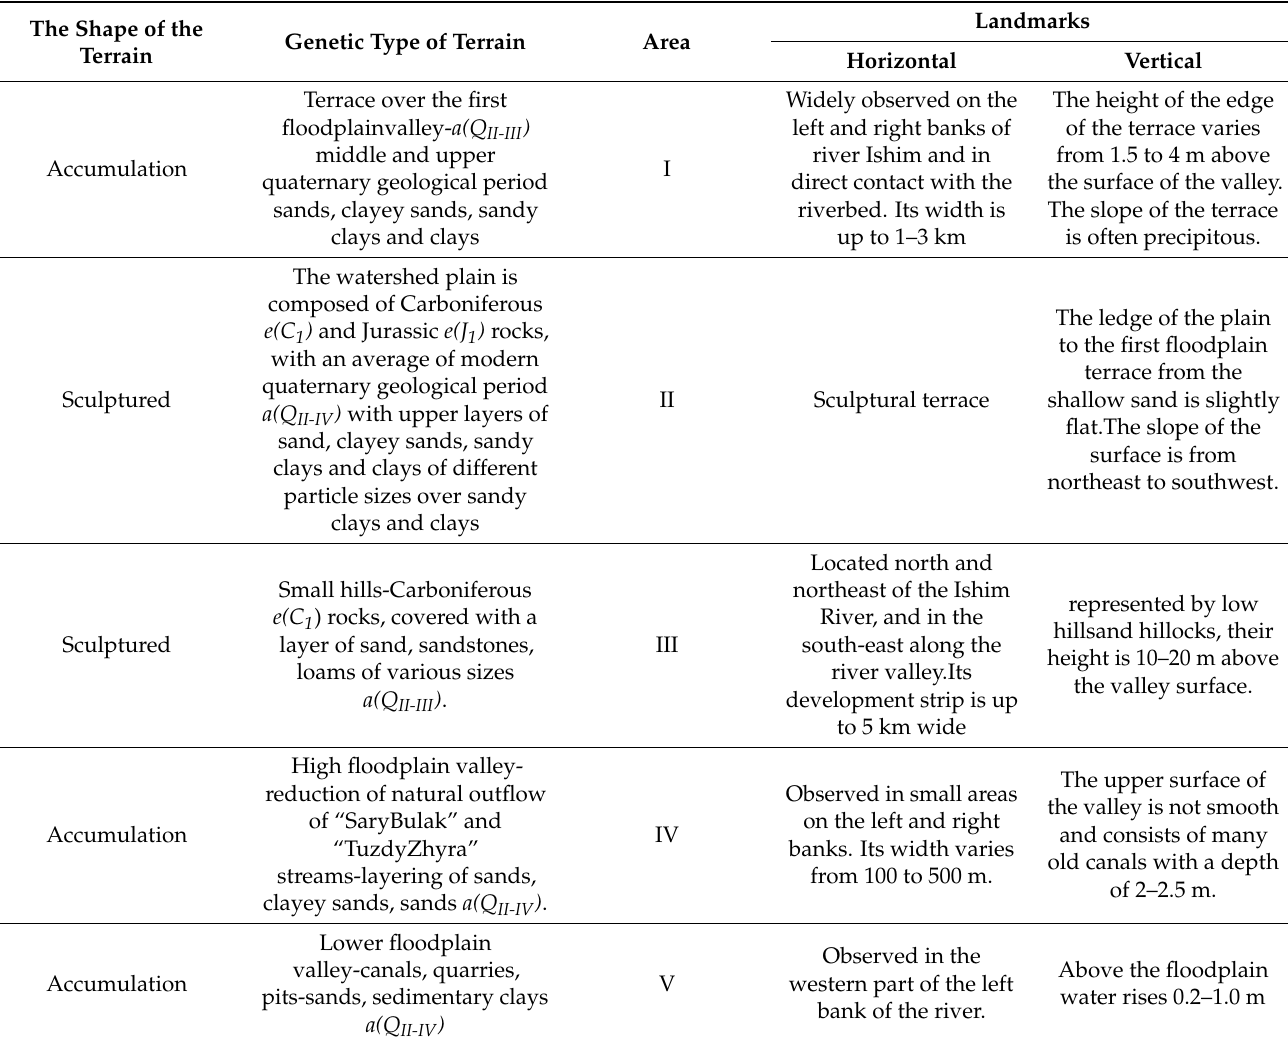
Table 1. Explanatory notes on the geotechnical map of